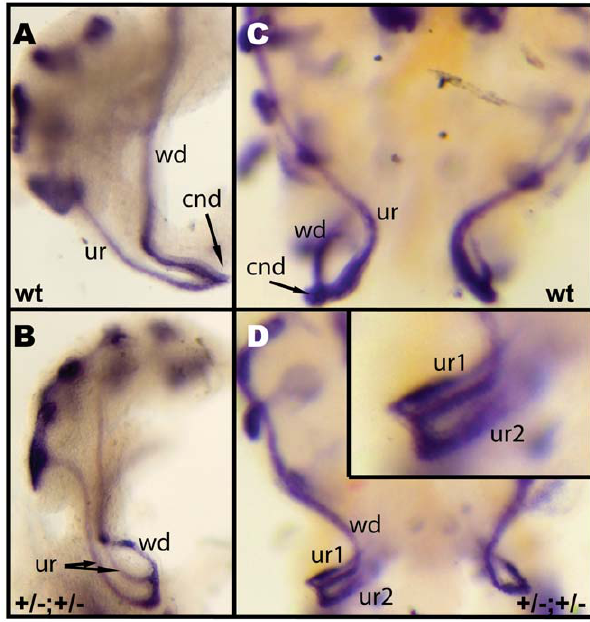
Figure 2. Ectopic ureter budding in Pax2 + / 2 ;Emx2 + / 2 embryos. (A–D) Whole-mount in situ hybridization with a Gata3 cRNA probe at E12.5. (A) Side view of wild-type (wt) urogenital system. (B) Compound heterozygote showing two independent ureters emerging from the caudal region of the Wolffian duct. (C) Ventral view of wild-type urogenital systems. (D) Pax2;Emx2 compound heterozygote showing bifid ureteric buds pointing in opposite directions. wd: Wolffian duct, ur: ureter, cnd: common nephric duct.